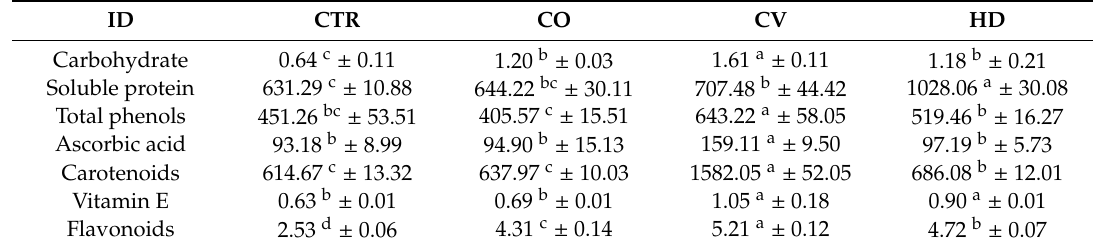
Table 2. Primary and secondary metabolites in red Topepo fruits grown in unfertilized soil (control, CTR) and soils fertilized with compost from olive wastes (CO), compost from vegetable wastes (CV), and horse dung (HD). Carbohydrate, soluble protein, ascorbic acid, carotenoids, and vitamin E were expressed as mg / 100 g FW. Total phenols were expressed as mg gallic acid / 100 g FW and flavonoids as rutin (R) E / g